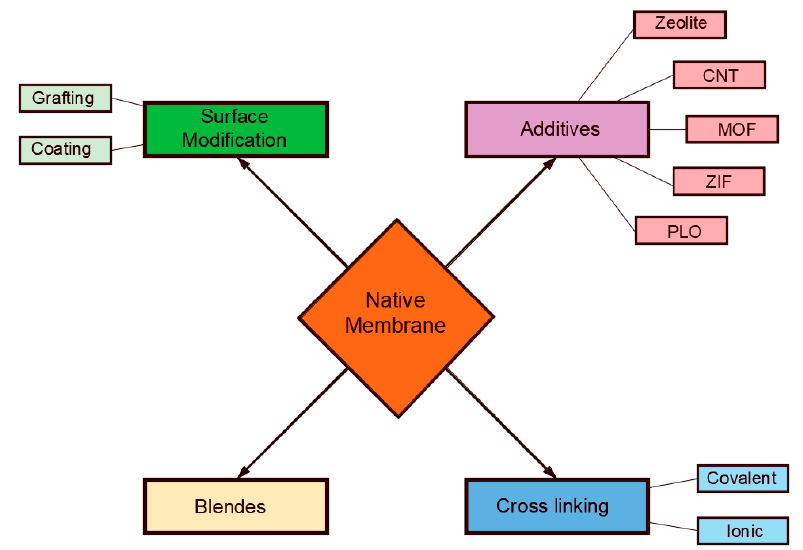
Figure 2. Schematic diagram of the different techniques that are used to modify the surface prop- erties of membranes. CNT: carbon nanotube, MOF: metal–organic framework, ZIF: zeolitic imidazolate frameworks, PLO: porous layer oxides (Reproduced with permission from [12]. Wiley, 2013.)